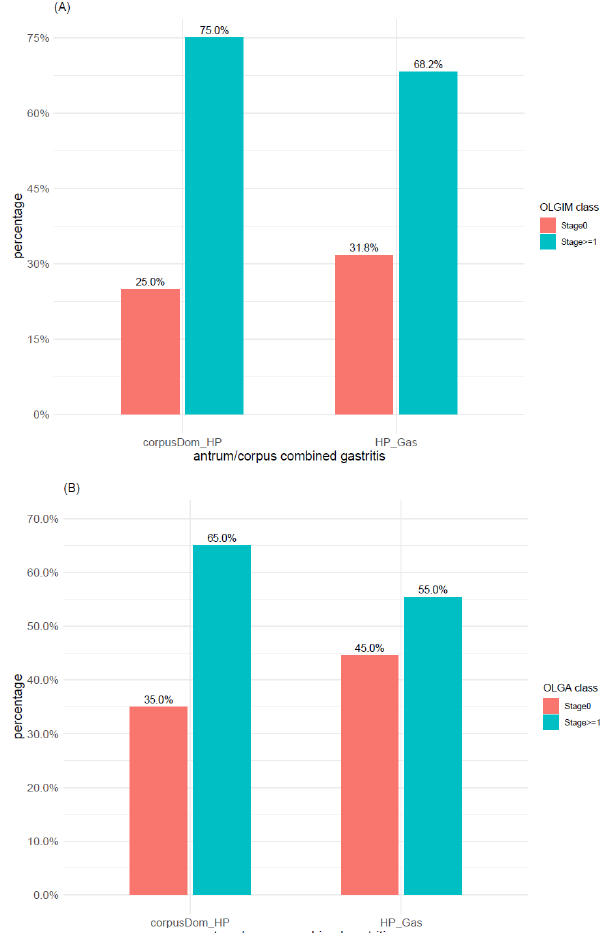
Figure 9. Comparison of H. pylori and Corpus dominant H. pylori gastritis with regard to ( A ) intestinal metaplasia and ( B ) atrophy. OLGA and OLGIM classes are grouped as stage 0 vs. stages 1–4. corpusDom_HP: Corpus Dominant H. pylori Gastritis; HP_Gas: H. pylori Gastritis; OLGA: operative link on gastritis assessment; OLGIM: operative link on gastric intestinal metaplasia assessment. Comparing Corpus dominant H. pylori gastritis versus conventional H. pylori gastritis based on the 2-level classification system low-/high-risk, 15/5 (75%) of Corpus dominant H. pylori gastritis and 180/211 (85%) of H. pylori gastritis cases were grouped as low-risk with OLGIM (Figure 10A), whereas 17/20 (85%) and 201/212 (94.8%), respectively, were grouped as low-risk with OLGA (Figure 10B).